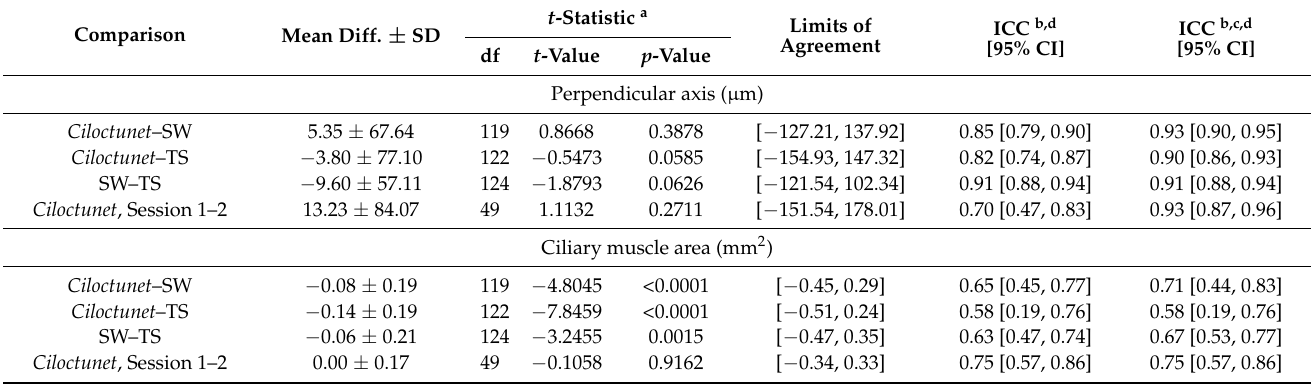
Table 4. Results of the paired samples t -tests between the biometric parameters perpendicular axis (PA) and ciliary muscle area (CMA), derived from the segmentations performed by the two examiners SW and TS, and Ciloctunet